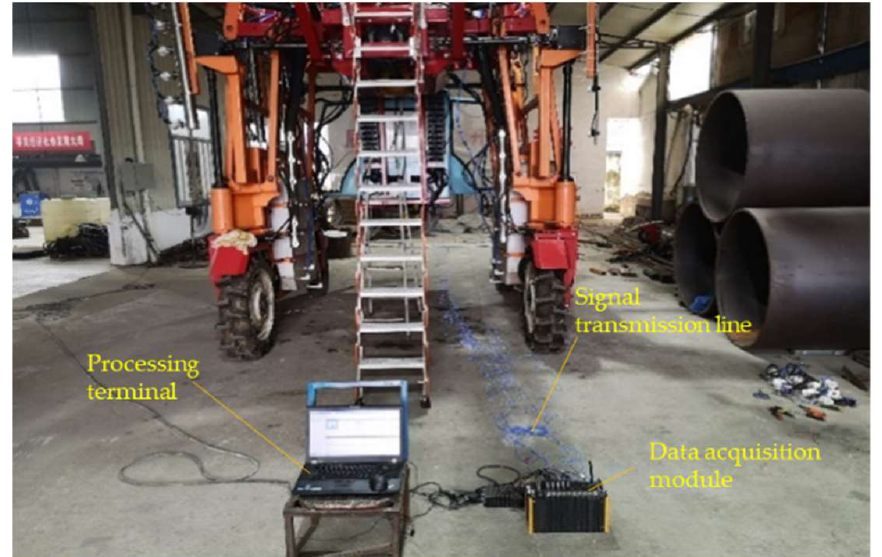
Figure 7. Site view of the vibration test on the frame of the sprayer frame.